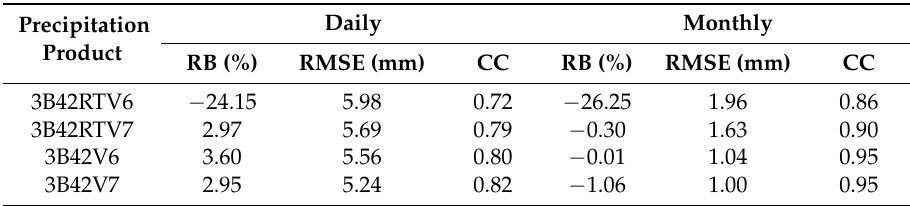
Table 3. The difference between the estimated precipitation of four satellite products and the observed precipitation in the Ganjiang River